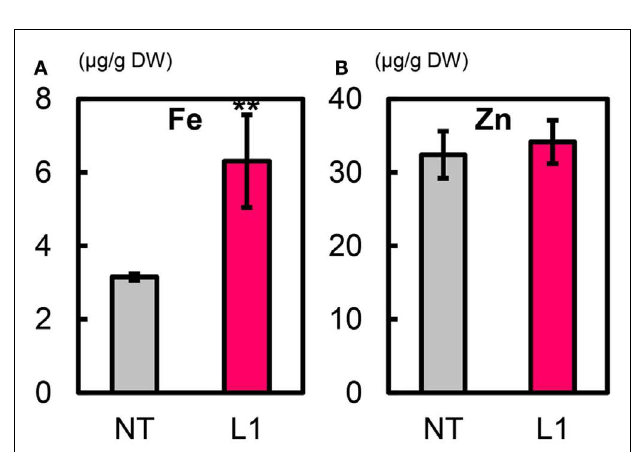
FIGURE 7 | Metal concentrations inT 1 polished seeds of Paw San Yin-Fer-NAS-YSL2 . (A) Fe concentration. (B) Zn concentration. NT, non-transgenic Paw SanYin. L1, Paw SanYin-Fer-NAS-YSL2 transgenic line 1. Bars represent means ± SE, n = 3. Asterisks ( ** ) above the bars indicate significant differences at P < 0.01 between NT and L1 (determined by t -test).